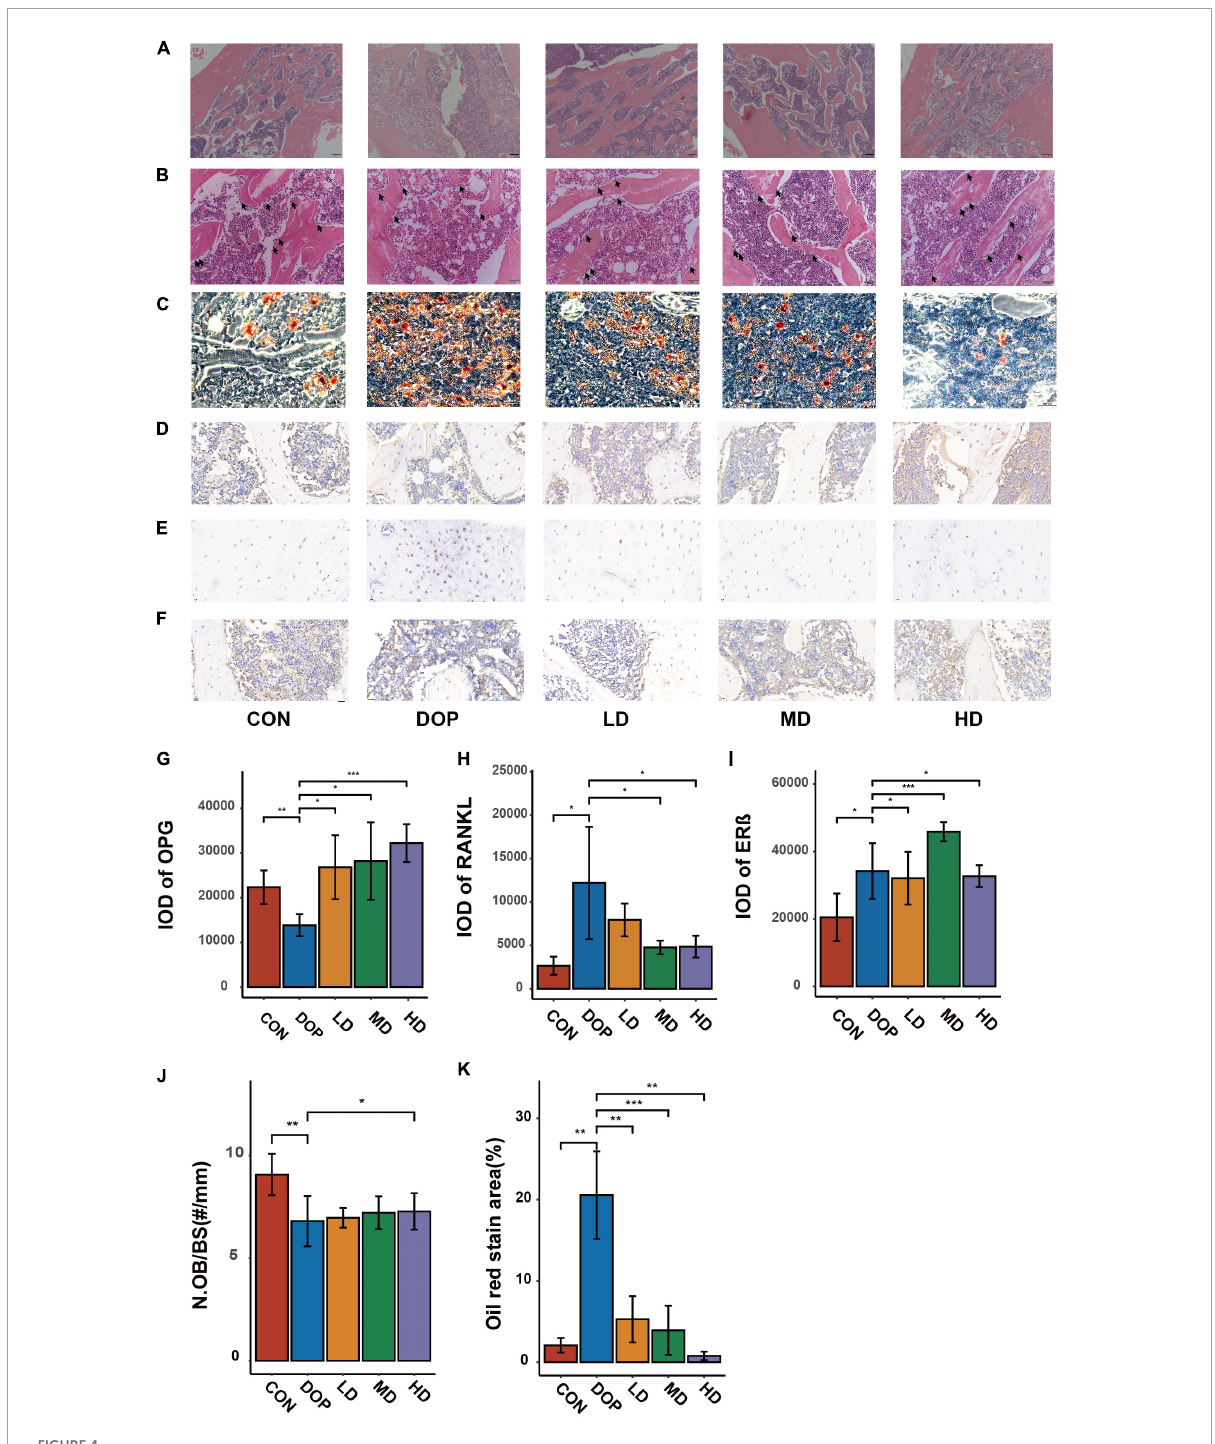
FIGURE4 Effects of S-Equol on hematoxylin and eosin staining histological changes, oil red O stain and immunohistochemical analyses of the distal part of the femoral metaphysis in different groups of rats. (A) Objective lens with a magnifying power of × 4 (Scale bars: 200 µ m); (B) Objective lens with a magnifying power of × 20 (Scale bars: 50 µ m); (C) Oil red O stain analysis of paraffin sections of the ictal part of the femoral metaphysis Objective lens with a magnifying power of × 4 (Scale bars: 200 µ m); Paraffin sections of the ictal part of the femoral metaphysis were prepared for immunohistochemical staining of OPG (D), RANKL (E) , and ER β (F) . The expression of biomarkers was scanned and evaluated by semiquantitative analysis with CaseViewer and ImageJ software (G–I) . Number of osteoblasts per trabecular surface of bone (N.Ob/BS) (J) . Quantitative analysis of Oil red O stain analysis (K) . All data are expressed as the mean ± SD ( n = 5). * p < 0.05, ** p < 0.01, *** p < 0.001 as compared to the diabetic osteoporosis (DOP)